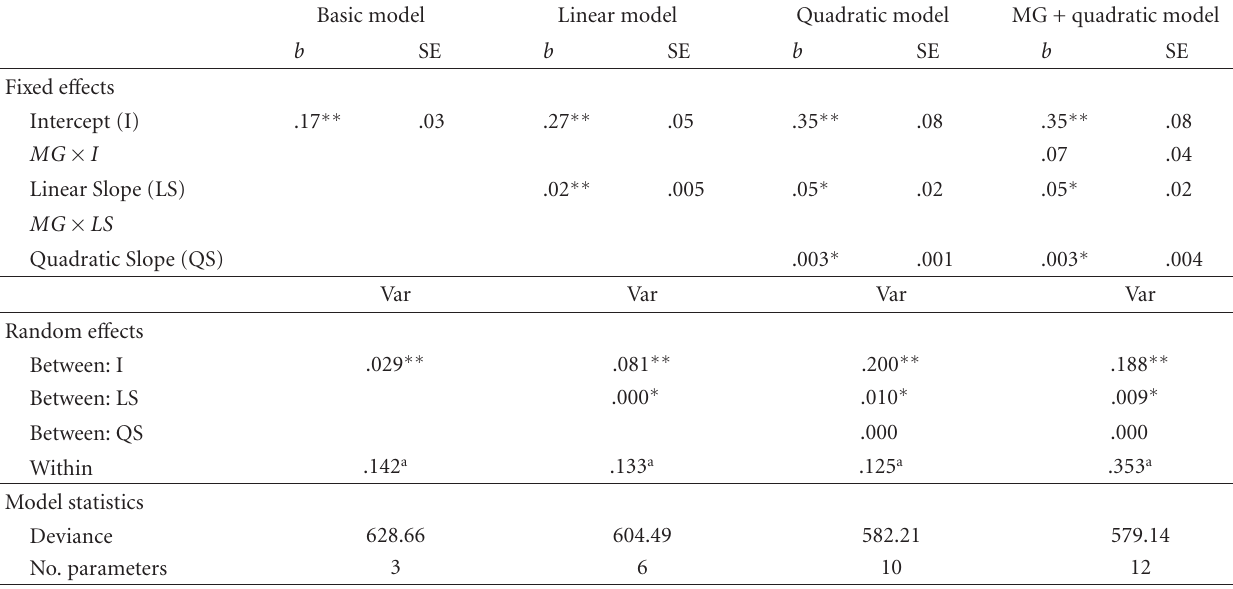
Table 6: Analysis of change in evaluation strategies prior to test